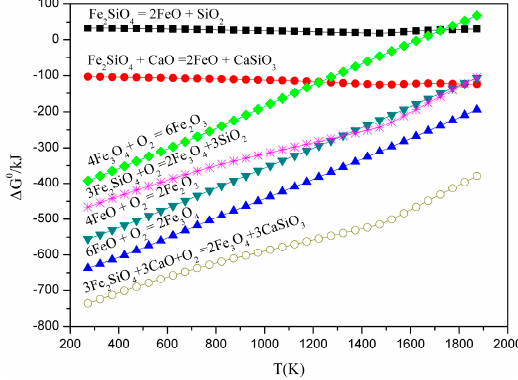
Figure 3. Relationship between ∆ G 0 and temperature.